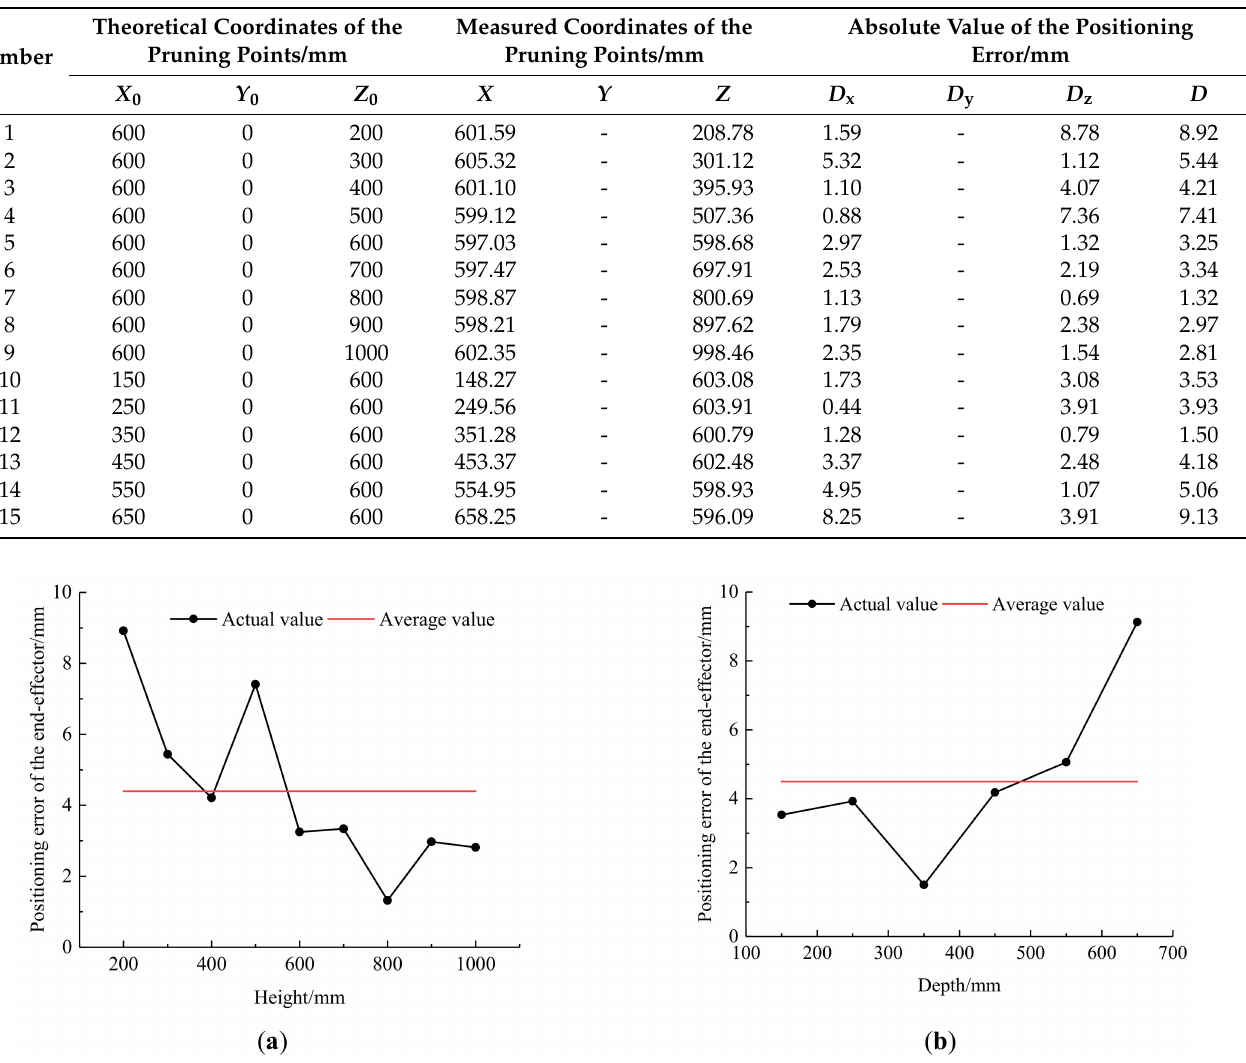
Table 3. The test results for the positioning error of the manipulator at different pruning points.